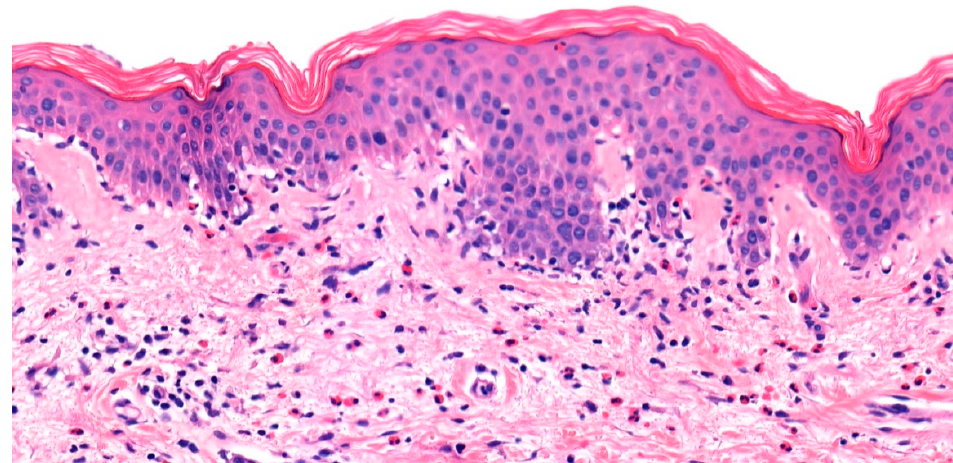
Figure 3. Urticarial bullous pemphigoid. Eosinophilic spongiosis characterized by pseudovacuolar change, eosinophil exocytosis, and dermal eosinophilia.